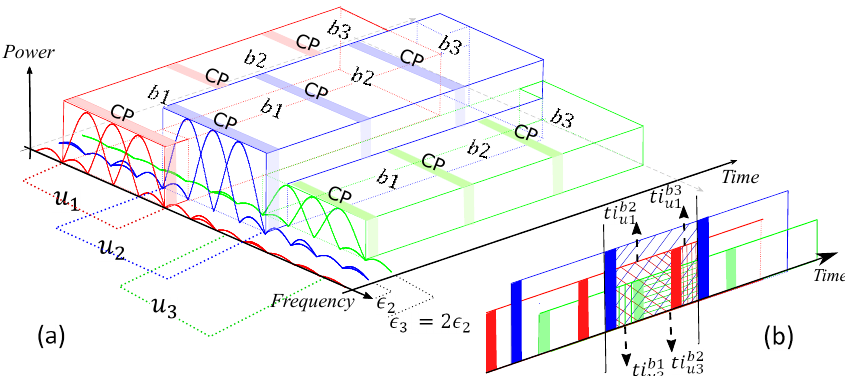
Figure 5. ( a ) Time, frequency and power domain illustration of three users’ signals. Each user’s signal is shown by different color. ( b ) Time domain representation of the superimposed signal at the